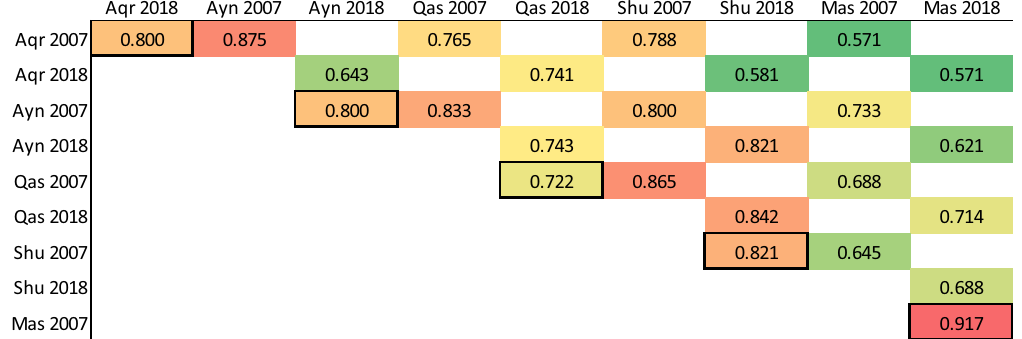
Table 3. Sørensen coefficient of similarity comparing the diversity of fruit trees in 2007 and 2018 within the oases* of Wadi Muaydin (2007 versus 2018, boxed values) and across oases (2007 and 2018, respectively). *Oases are abbreviated with the three first letters of their main name. For Qanfarah only data of 2018 was available, therefore it is not included